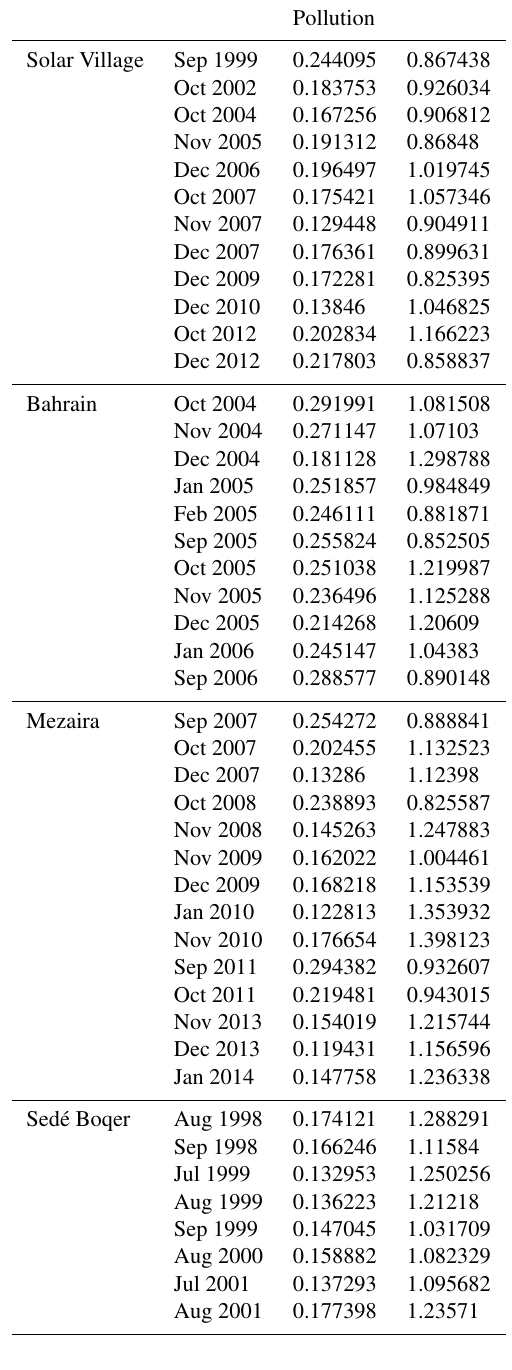
Table 4. Seasonal pollution domination over study